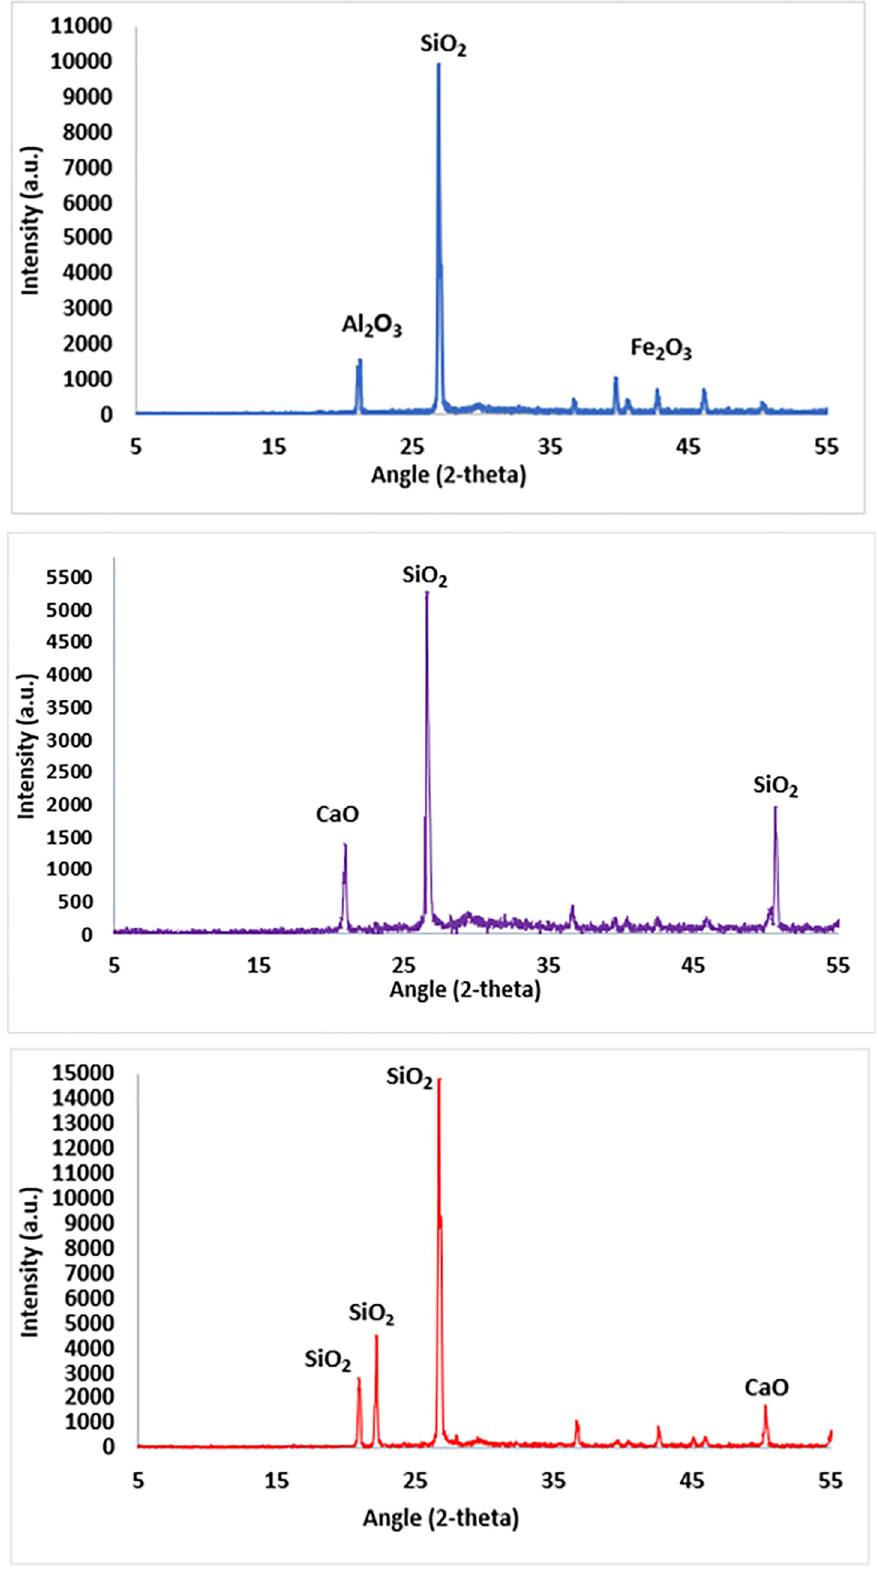
Fig 1. XRD analysis of (a) Silica Fume (SF), (b) Granulated blast furnace slag (GBFS), and (c) Nano-silica (NS). https://doi.org/10.1371/journal.pone.0282435.g001 PLOS ONE | https://doi.org/10.1371/journal.pone.0282435 April 20,